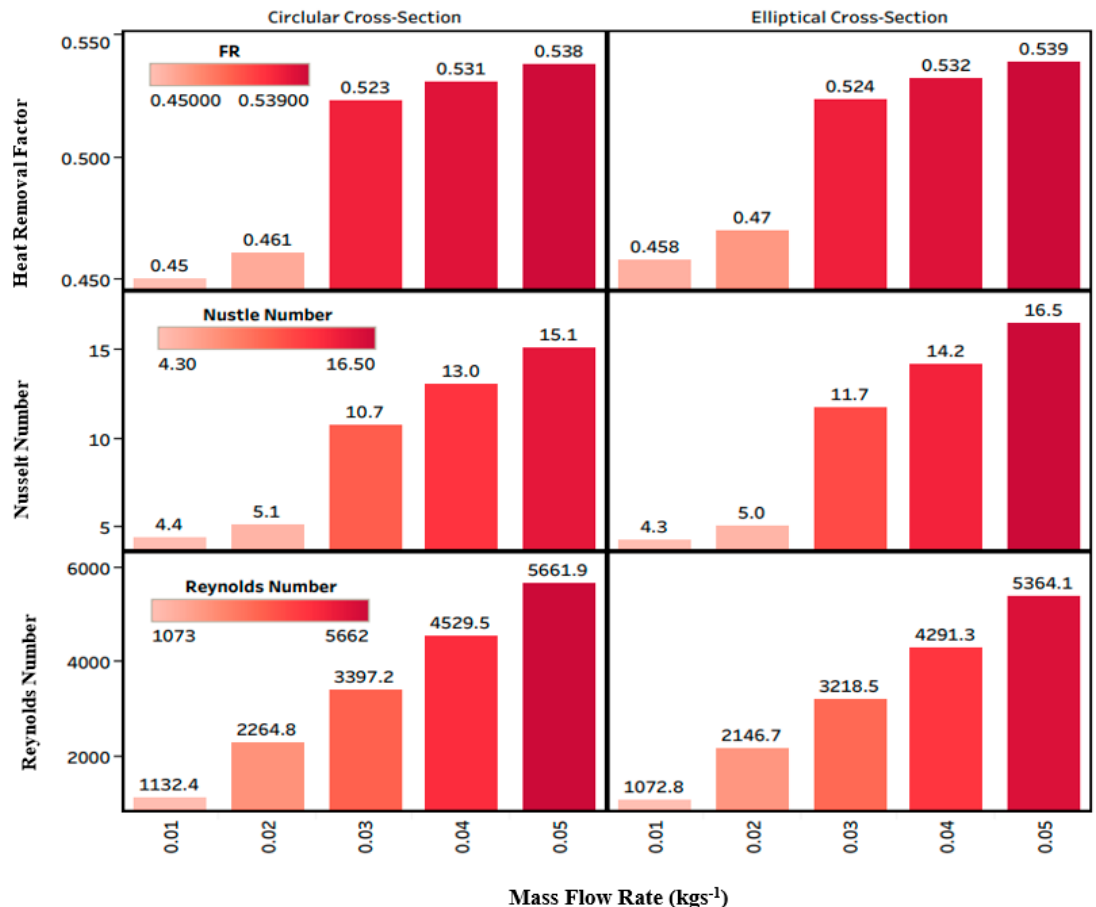
. m on the Re , Nu , and F R